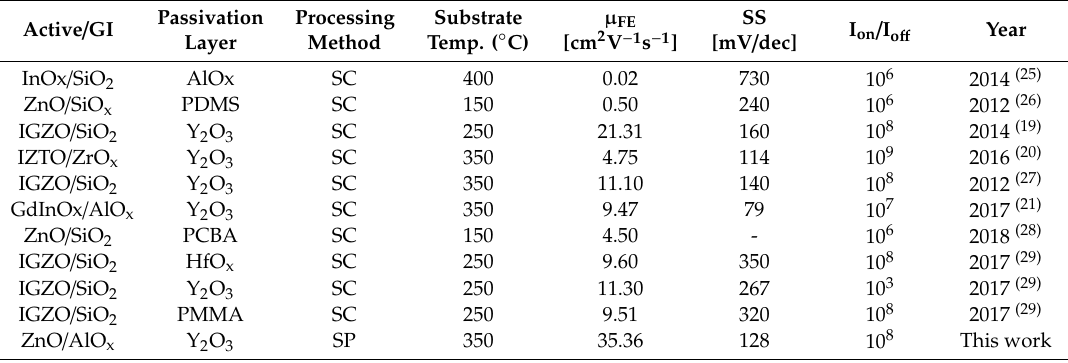
Table 1. The summary of processing methods and electrical performances (field e ff ect mobility, subthreshold swing, and current on / o ff ratio) of the solution processed oxide TFTs with various passivation layers.